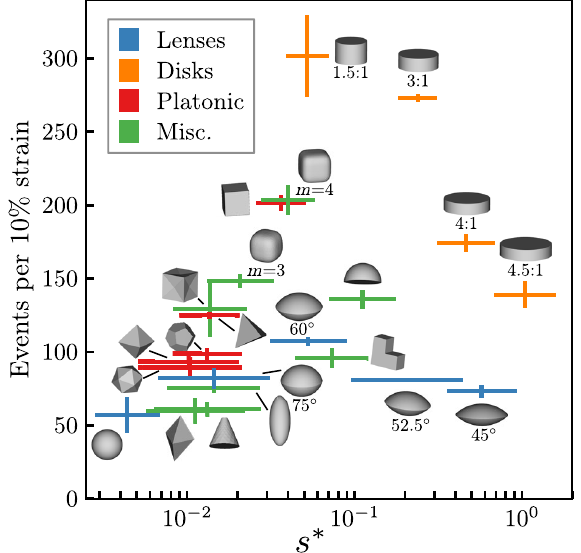
(2010).FIG. 8. Detectable event rate versus slip event magnitude upper cutoff. Uncertainty for the event rate is calculated as the standard error of the mean count per